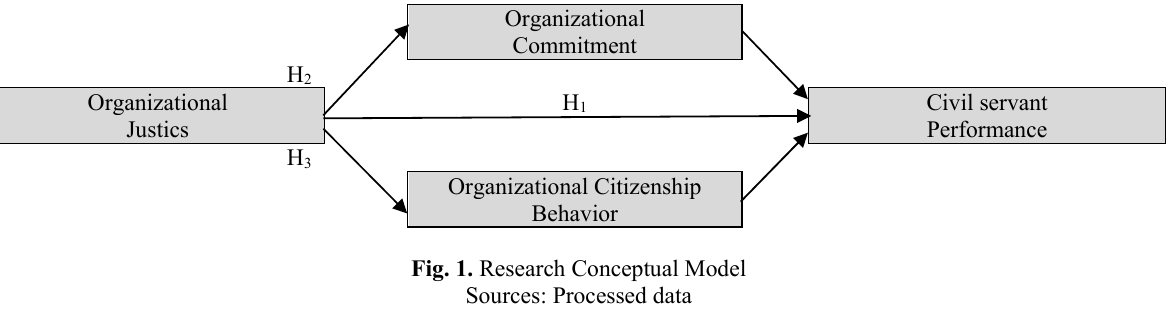
Fig. 1. Research Conceptual Model Sources: Processed